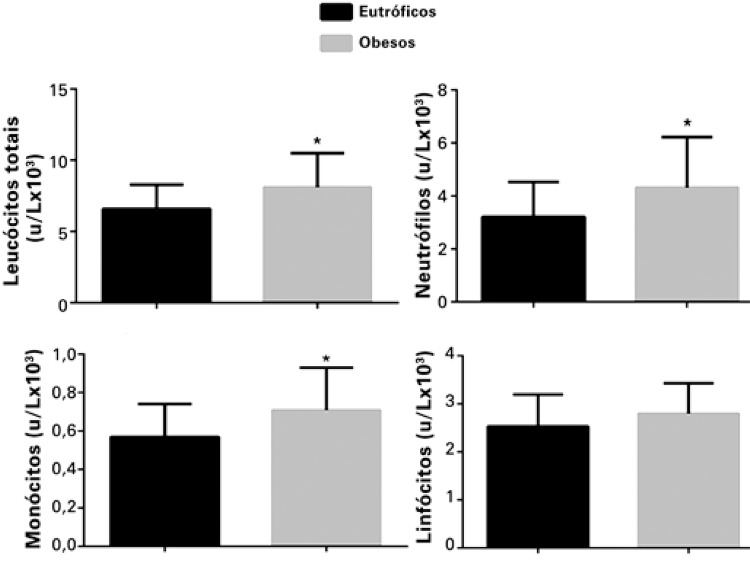
Comparação da contagem de leucócitos e subpopulações de adolescentes obesos e eutróficos. *p<0,05